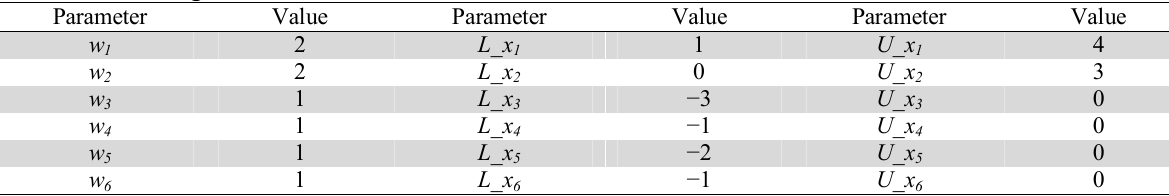
Parameter settings for the